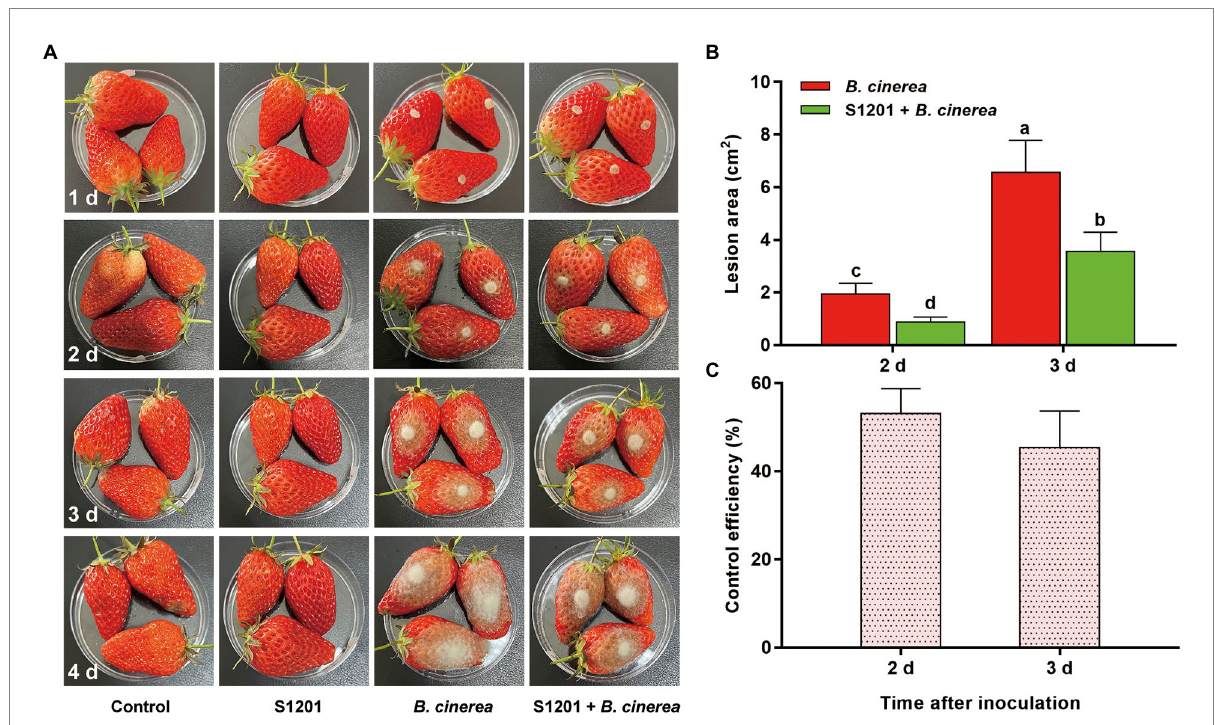
FIGURE 6 Bioassay of fermentation broth against B. cinerea on detached strawberry fruits. (A) Symptoms on strawberry fruits in different treatments. (B) Lesion area on strawberry fruits in B. cinerea and S1201 + B. cinerea treatment at 2 d and 3 d. (C) Control efficiency of fermentation broth against B. cinerea at 2 d and 3 d. Vertical bars represent the standard errors of the means. Different letters above the bars indicate statistically significant differences at p <